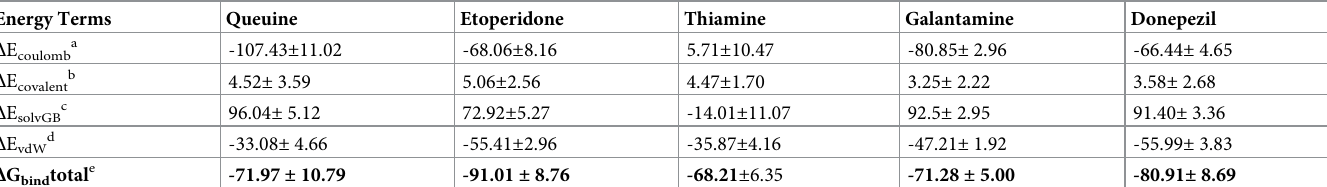
Table 3. MM-GBSA calculations from MD simulations.